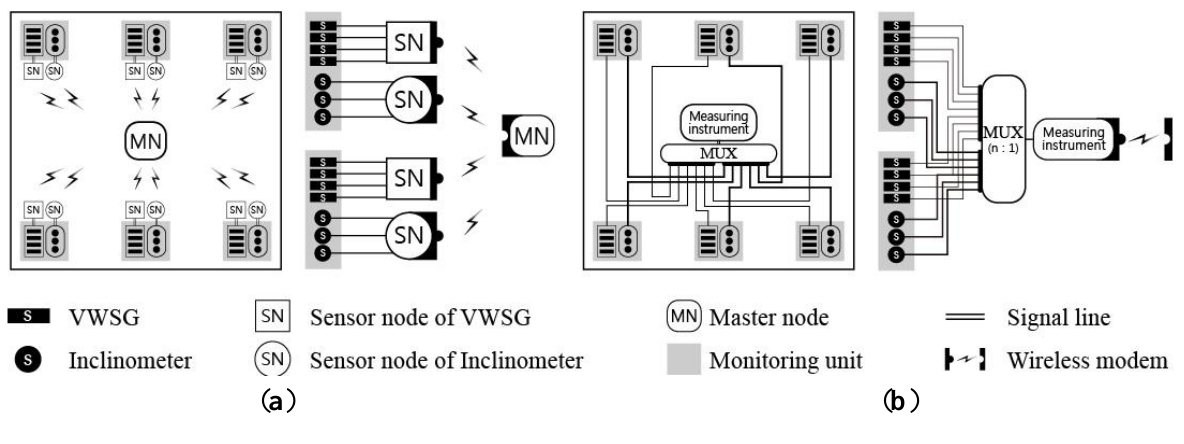
Figure 6. Comparison of the length of the signal line. ( a ) Wireless sensor network; ( b ) General sensor